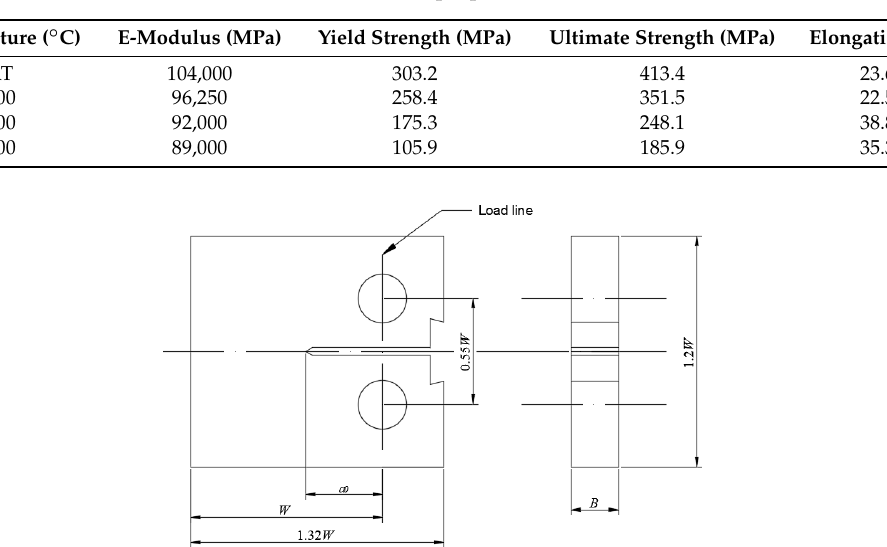
Figure 1. Schematic drawing of the tensile specimen. Table 2. Mechanical properties of CP-Ti.